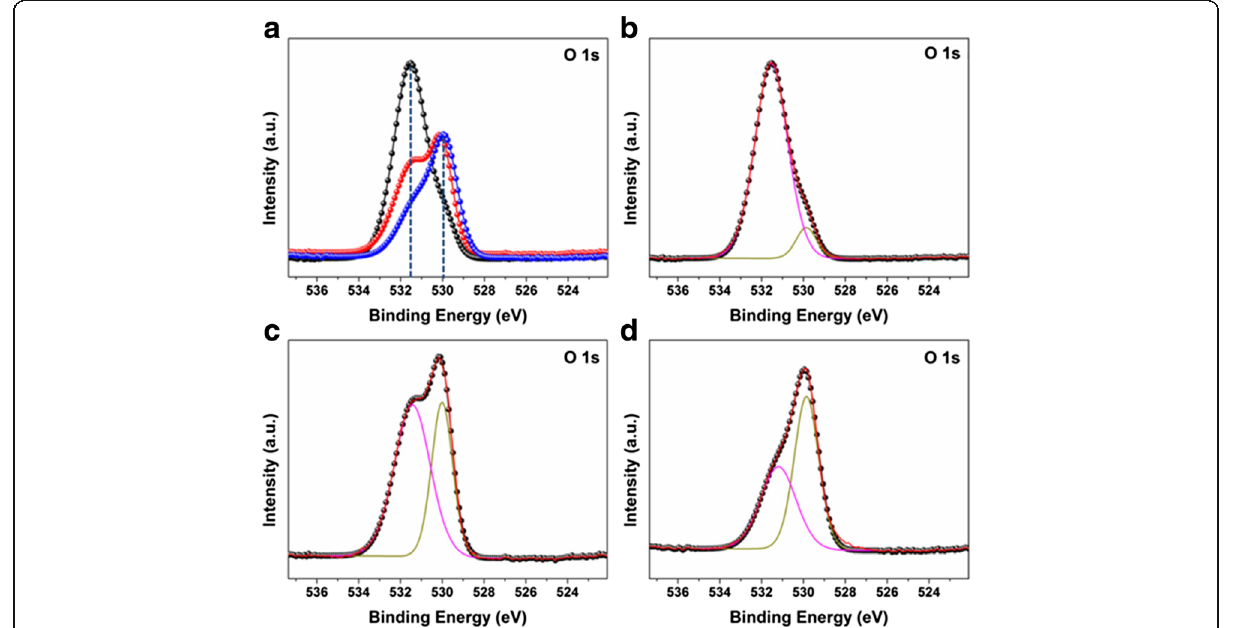
Fig. 5 The O 1s core spectrum and its deconvolution of 150 cycles of ALD ZnO coating PA 6 with a 0, b 1, c 3, and d 6 h hydrothermal reactions,